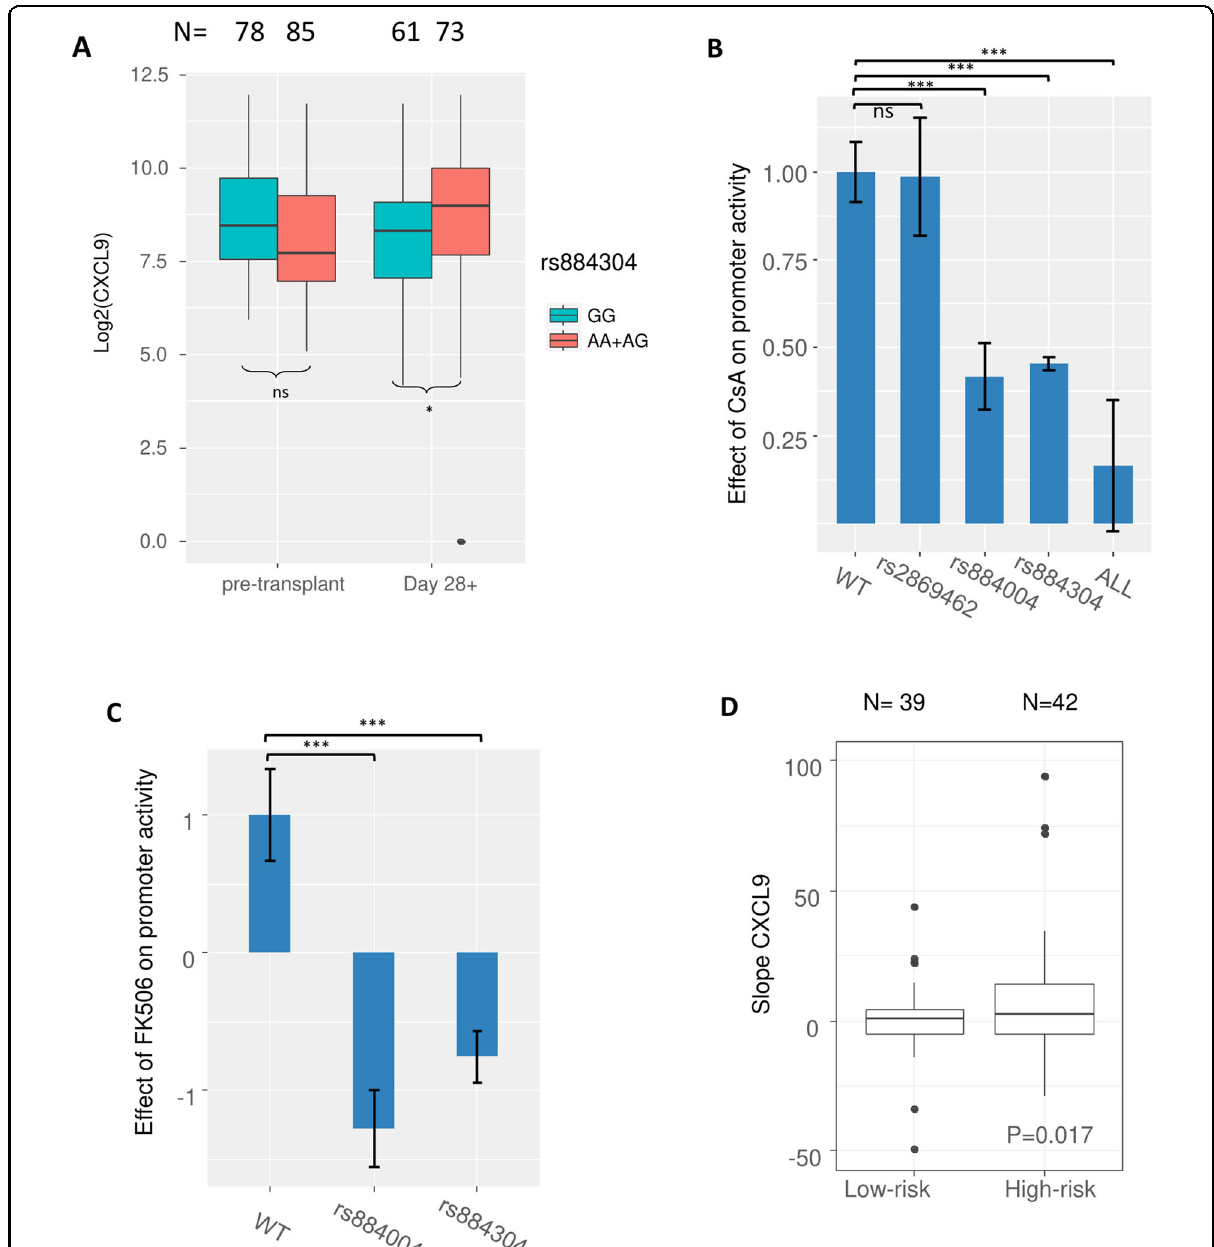
Fig. 3 The association of rs884304 with IFN- γ induced promoter activity and CXCL9 recovery. A In patients, high-risk genotypes (AA + AG) of genetic risk group A (rs884304) were associated with signi fi cantly higher day + 28 serum CXCL9 levels, but not with pre-transplant CXCL9. B In luciferase reporter assays, IFN- γ activation revealed that the constructs carrying variant allele of rs884304 ( P < 0.001), rs884004 ( P < 0.001), and the one carrying variant alleles of all the three SNPs ( P = 0.001), but not rs2869462, were associated with signi fi cantly reduced suppressive effect of CsA compared to the wild-type construct. The results were collected from three independent experiments. Luciferase activity was normalized to 1 relative to the WT and all data were plotted as the mean ± SEM. C Similar to ( B ), with FK506 (tacrolimus) as calcineurin inhibitor. Results were collected from three independent experiments. Luciferase activity was normalized to 1 relative to the WT and all data were plotted as the mean ± SEM. D Recovery rates of CXCL9 serum levels in patients from the lowest value post alloSCT until day 28 + in the presence of calcineurin inhibitors (slope CXCL9) was higher in the genetic high-risk group. n.s. not signi fi cant; * P ≤ 0.05; *** P <